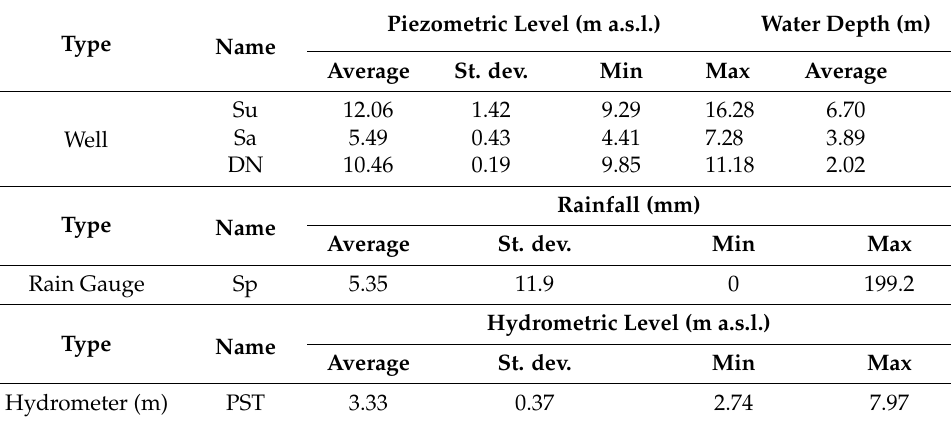
Table 2. Average and standard deviation of the piezometric level, rainfall and hydrometric level time series